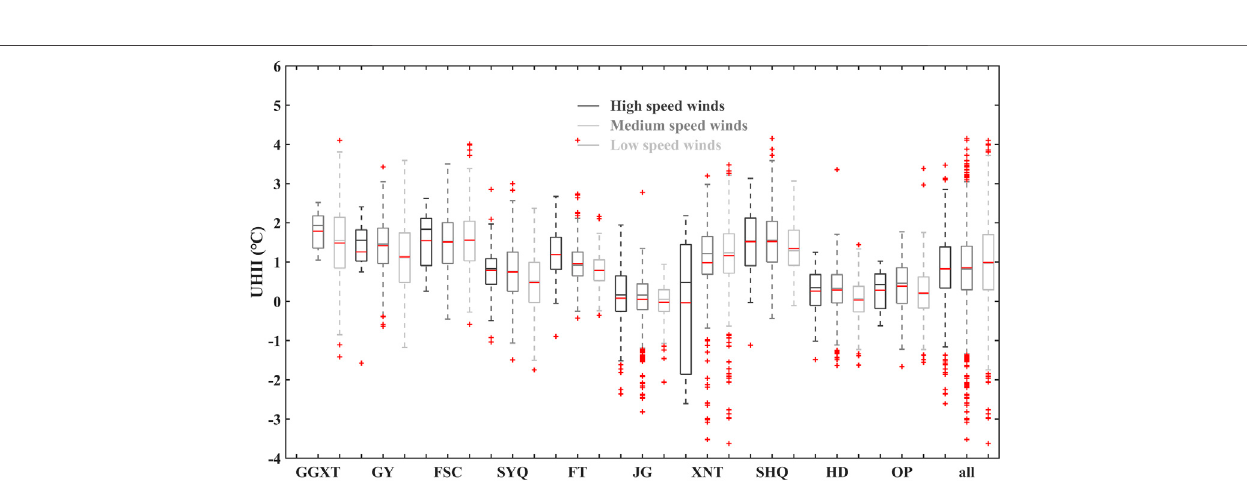
signi fi cant, with F (6418) (cid:1) 18.46 and p < 0.001. Under high wind